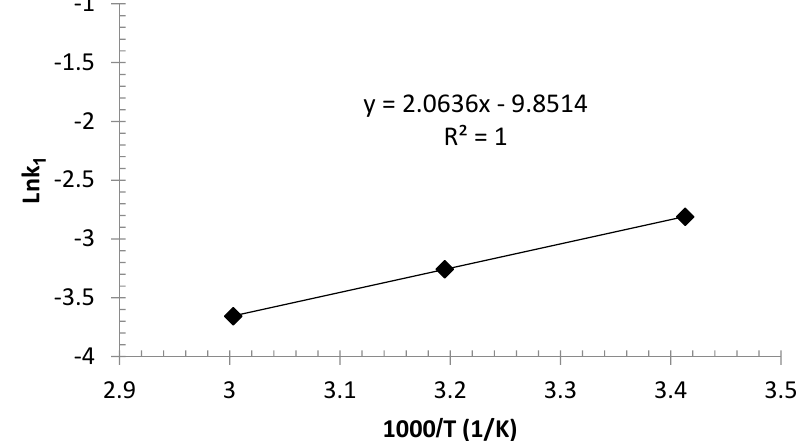
Figure 14. Kinetics of arsenic adsorption at three different temperatures.